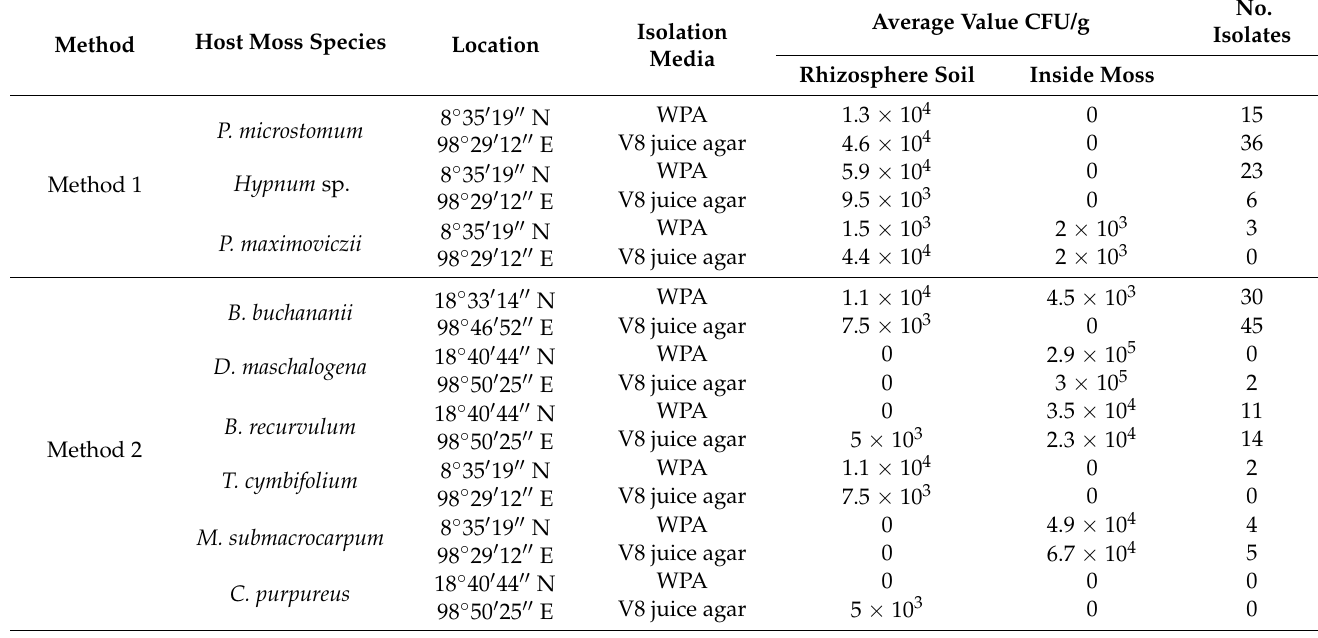
Table 1. Actinobacteria obtained from mosses using two different methods. Method 1 used